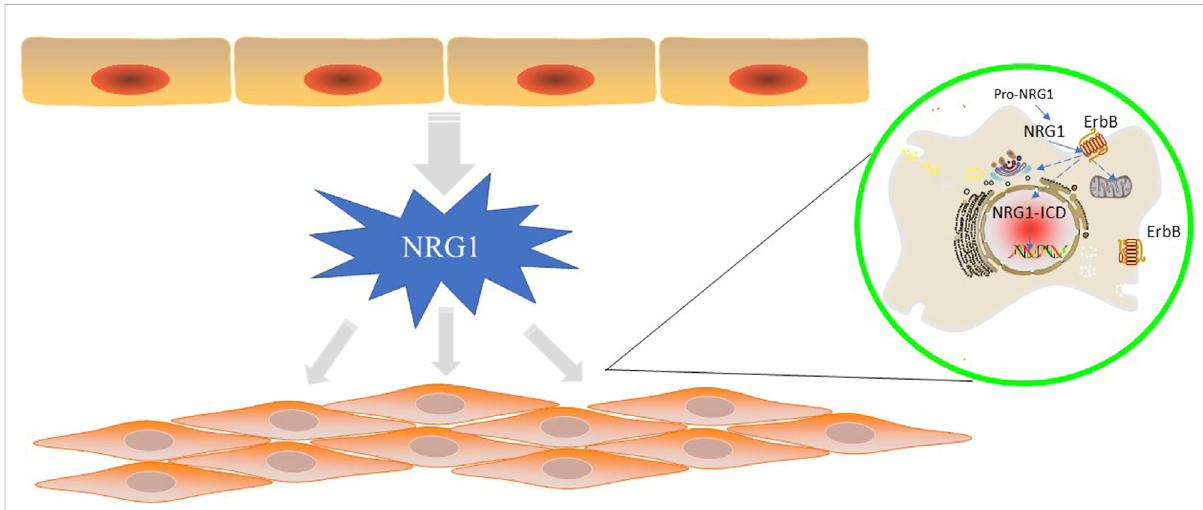
FIGURE 1 NRG1 is secreted by endothelial cells in the cardiovascular vessels and function in endothelial cells or cardiomyocytes by ErbB proteins. In “ reverse signaling ” , the C-terminal fragment of pro-NRG1 is generated by extracellular cleavage to release mature NRG1 and is further cleaved by γ - secretasetogenerateNRG1-ICD,whichrelocatestothenucleustoregulategenetranscription.Intypicalpositivesignaling,NRG1bindstoErbB3and ErbB4ECDindifferentiatedcardiomyocytesandinducesconformationalchanges,gaining higheraf fi nityforotherErbBreceptors.NRG1ligand binding triggers homodimerization of ErbB4 and heterodimerization of ErbB2/3, ErbB2/4, ErbB3/4, followed by downstream signalling through the central